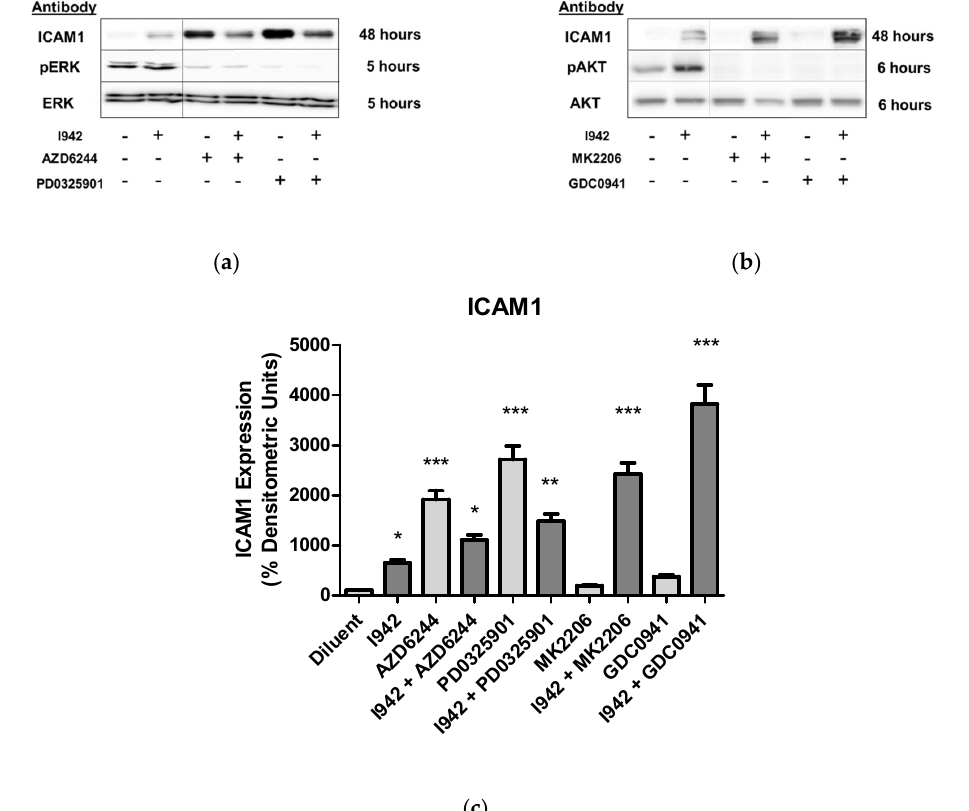
Figure 10. ( a ) HUVECs were stimulated for the indicated times with the MEK inhibitors, AZD6244 or PD032590, in the presence or absence of 100 µ M I942. Cell extracts were then prepared and immunoblotted with anti-ERK and phospho-ERK antibodies or anti-ICAM1 antibodies, as indicated. ( b ) HUVECs were stimulated for the indicated times with the PI3 kinase inhibitor, GDC0941 (10 µ M), or the AKT inhibitor, MK2206 (10 µ M). Cell extracts were then immunoblotted with anti-AKT and phospho-AKT antibodies or anti-ICAM1 antibody. ( c ) ICAM1 densitometric values from 3 separate immunoblots are shown as a bar graph with significant changes in ICAM1 expression, relative to cells stimulated with diluent alone being indicated; * p < 0.05, ** p < 0.01, *** p < 0.001.